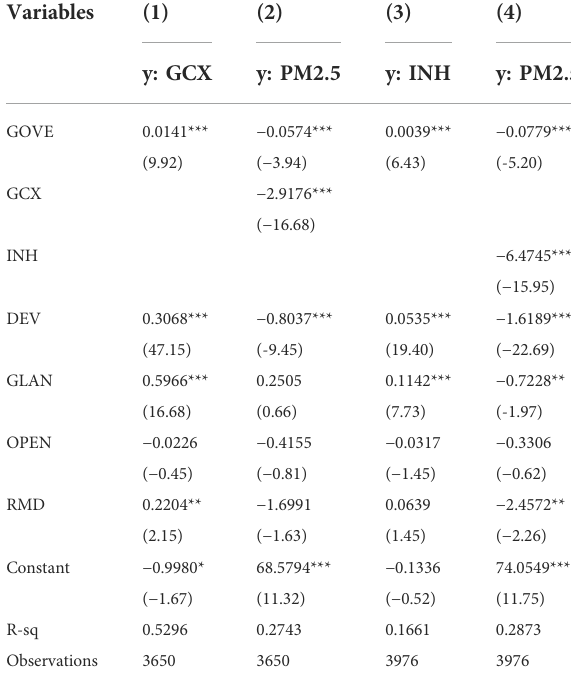
TABLE 3 Intermediary mechanism of government environmental concerns on the impact of haze.